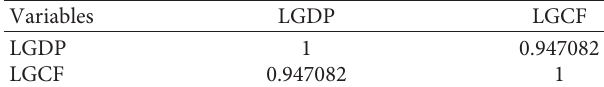
Table 5: Correlation between LGDP and